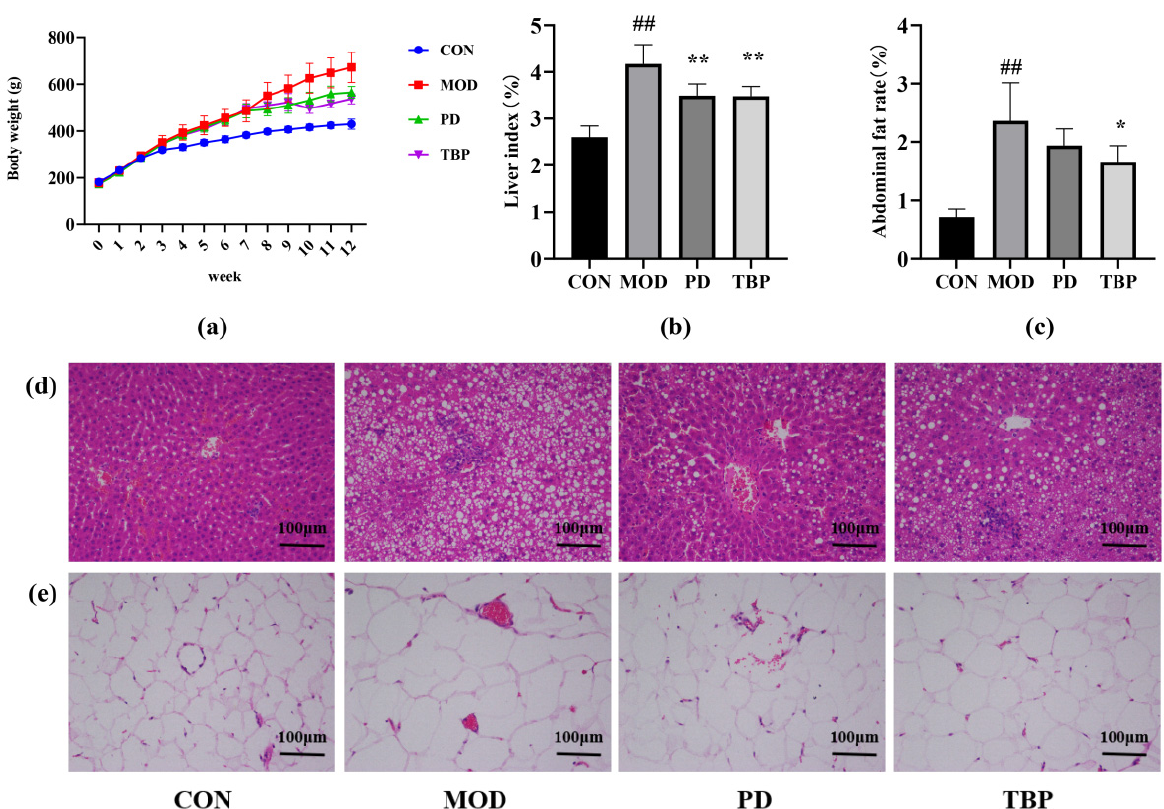
Figure 3. Effect of TBP on body weight ( a ), liver index ( b ), and abdominal fat rate ( c ) in rats consuming a HFD. Histopathological examinations of liver ( d ) and epididymal adipose ( e ) tissues using HE staining (200 × ). Values are expressed as the mean ± SD ( n = 6) for all groups. ## p < 0.01 denotes statistically significant differences between the CON and MOD groups. ** p < 0.01 and * p < 0.05 denote statistically significant differences with MOD group.